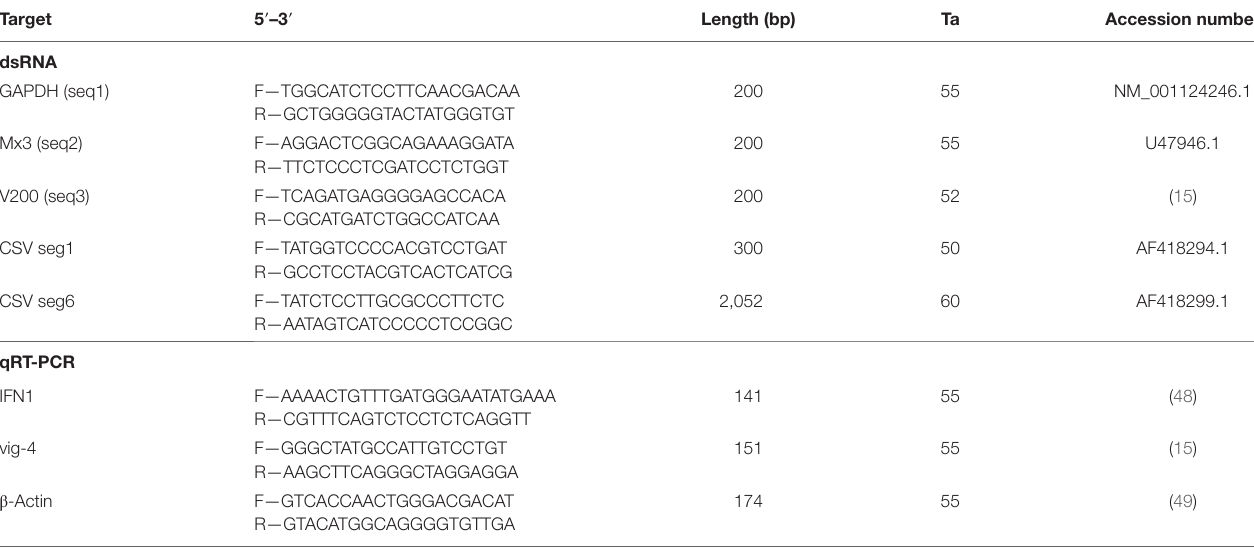
Table 1 | Primers used for in vitro transcription of dsRNA and qRT-PCR.